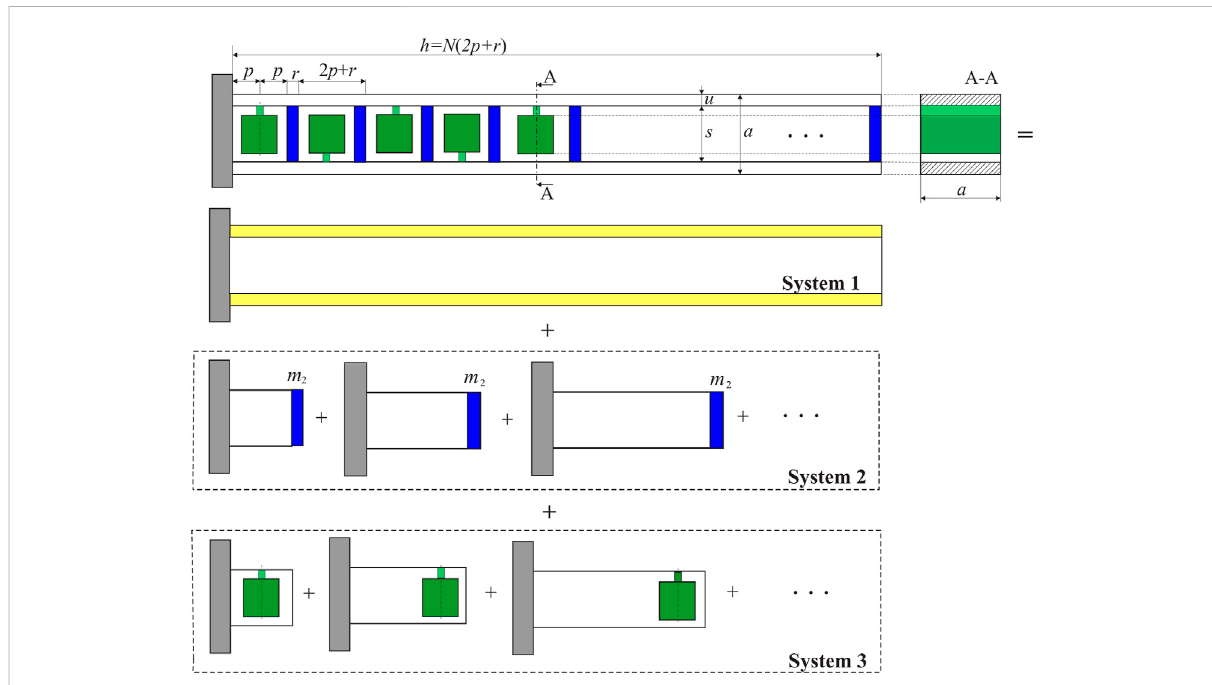
FIGURE 1 Metastructure under consideration in different con fi gurations: System 1 ( fi xed-free rod), System 2 (additional parts with transversal masses connected in series), and System 3 (parts with internal